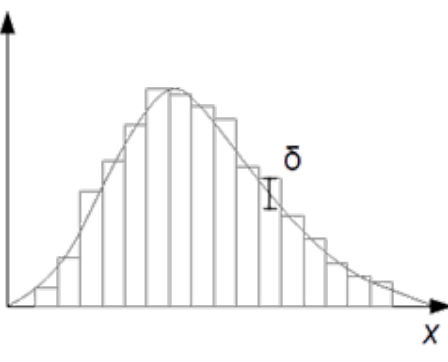
Fig. 3. The probability density of the reflected signal